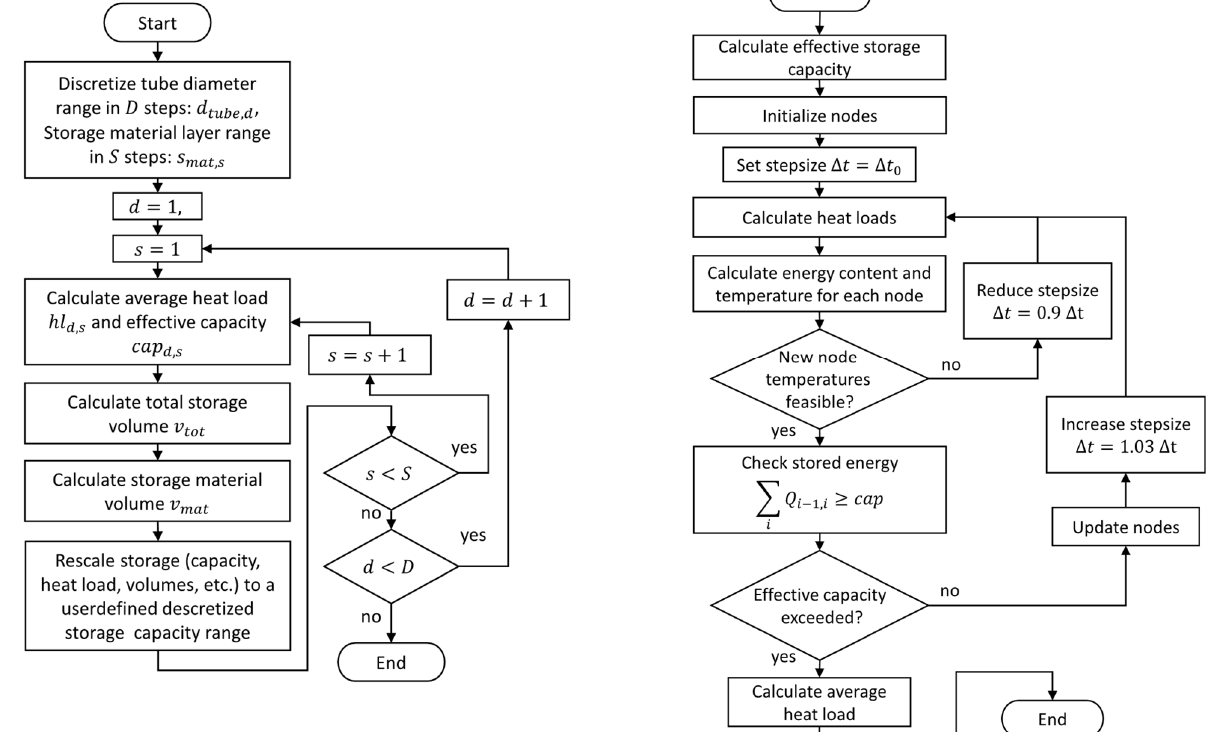
Figure 5. Schematic of the node model for LHTS and concrete storage.